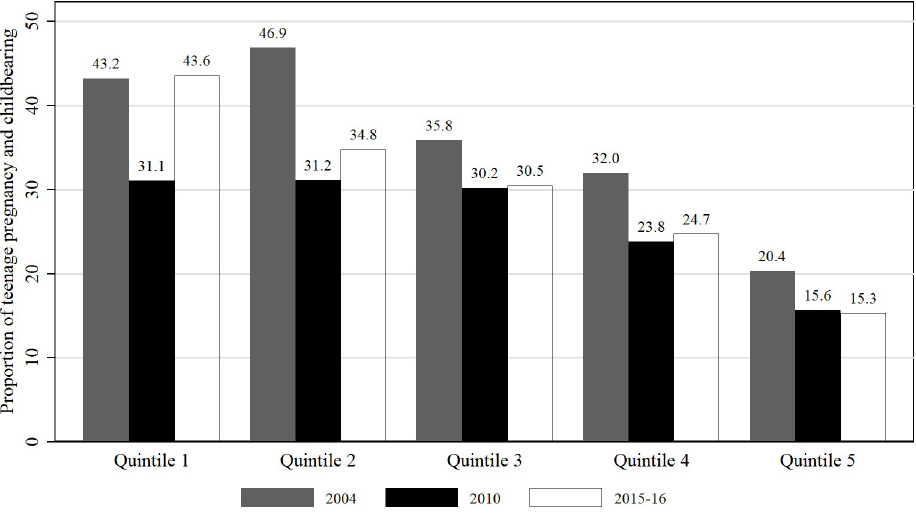
Fig 1. Teenage pregnancy and childbearing trend by wealth status 2004-2015-16. Constructed by authors from MDHS 2004, 2010, 2015–16.